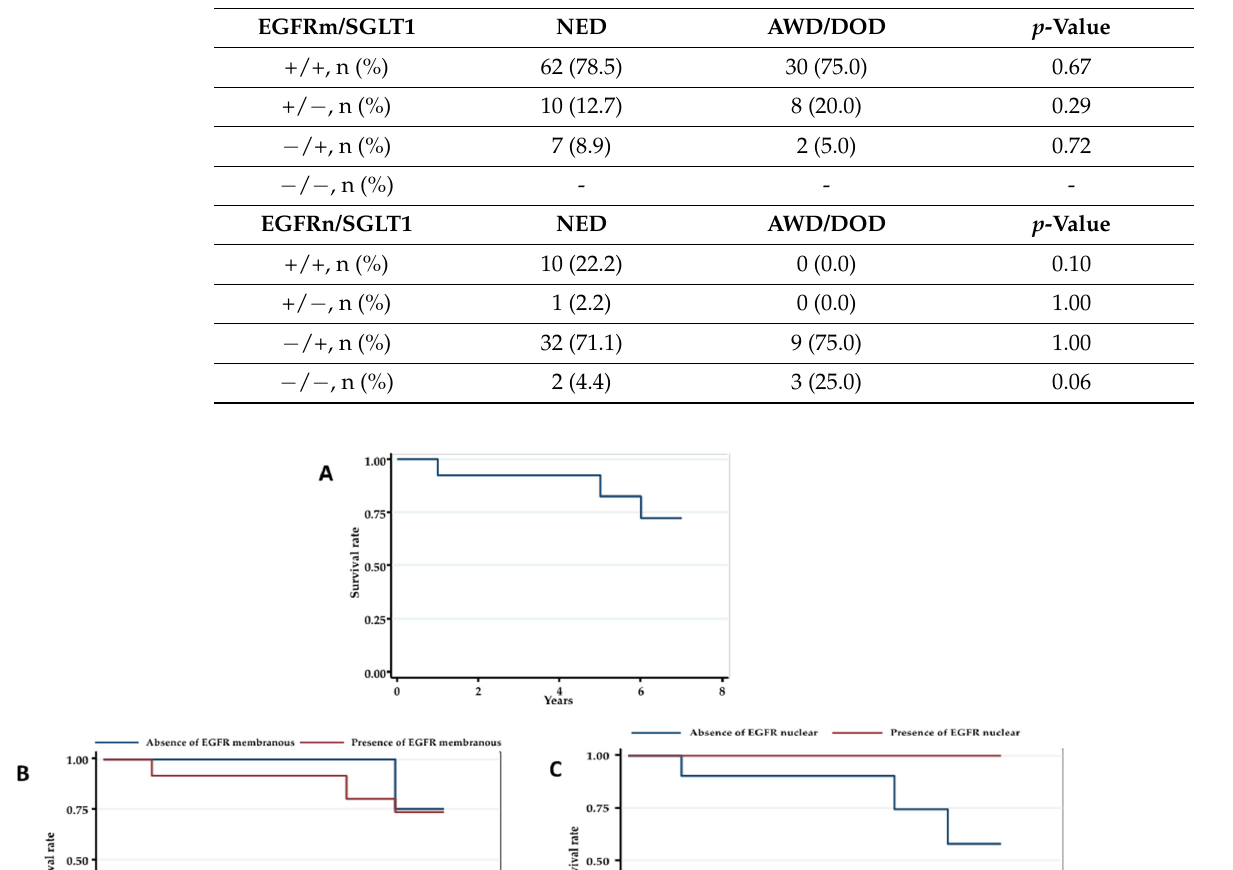
Table 6. Correlation between membranous EGFR, nuclear EGFR and SGLT1 expression levels combination and CCRCC patients with NED, AWD or DOD.